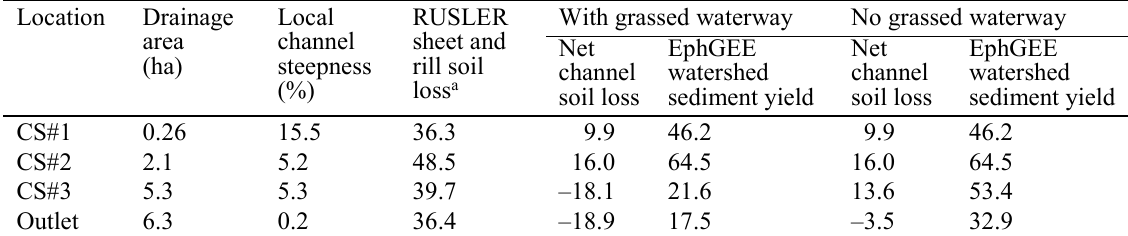
Table 1 Average RUSLER sheet and rill erosion and EphGEE watershed sediment yields and net channel erosion/deposition upslope of selected channel cross section locations (Fig. 1). Units: Mg ha -1 year -1 unless specified.